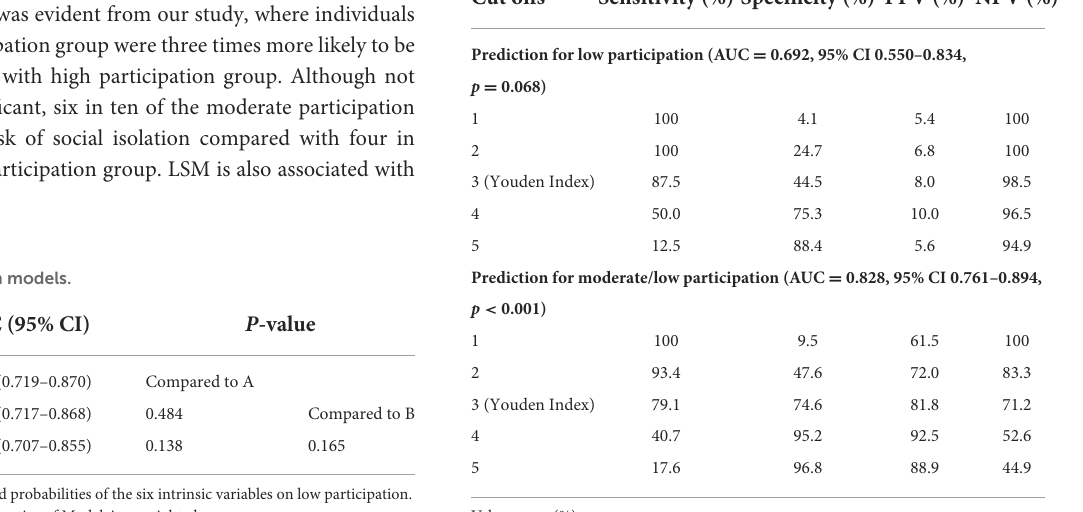
TABLE 6B Prediction model and participation group.